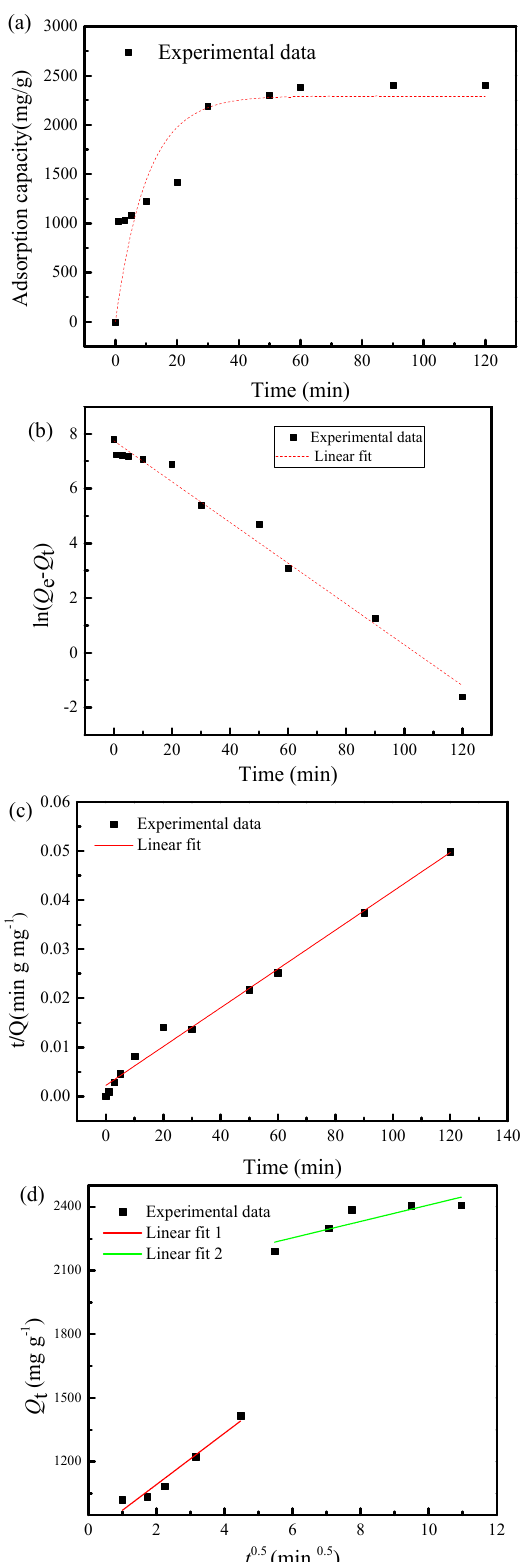
Figure 7. ( a ) The adsorption capacity at different times. Pb(II) removal by silk fibroin mediated nanoflowers ( b ) the pseudo ‐ first ‐ order; ( c ) the pseudo ‐ second ‐ order; ( d ) the intra ‐ particle diffusion model sorption kinetics curves.